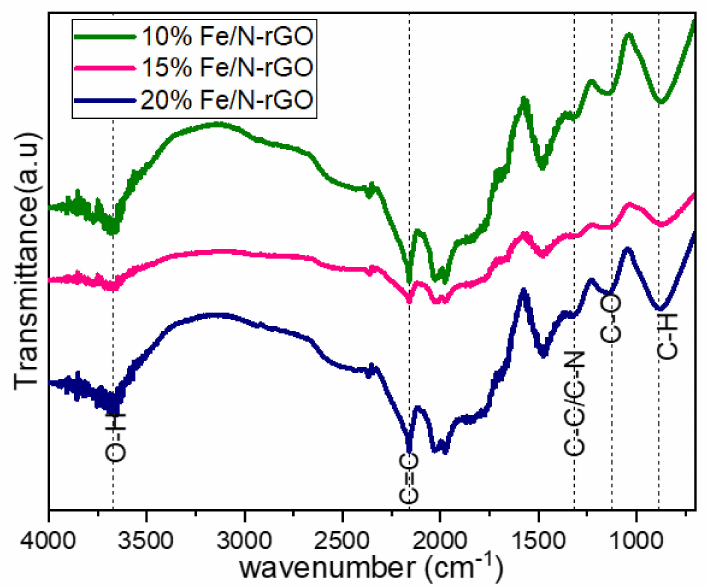
Figure 3. Fourier transform infrared (FTIR) spectra of 10% Fe/N-rGO, 15% Fe/N-rGO and 20%